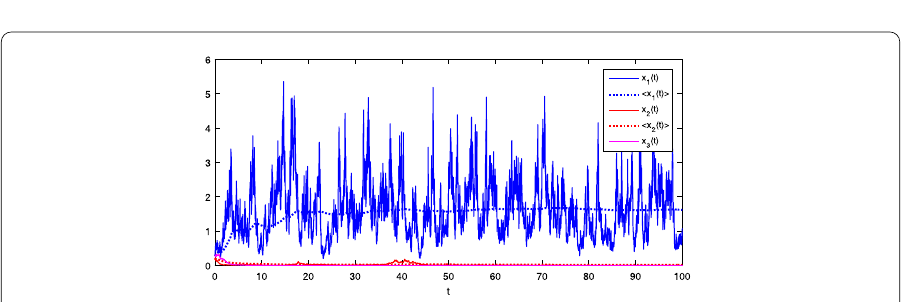
Figure 4 Species x 1 ( t ) is persistent in the mean, species x 2 ( t ) is extinct in the mean and x 3 ( t ) is extinct